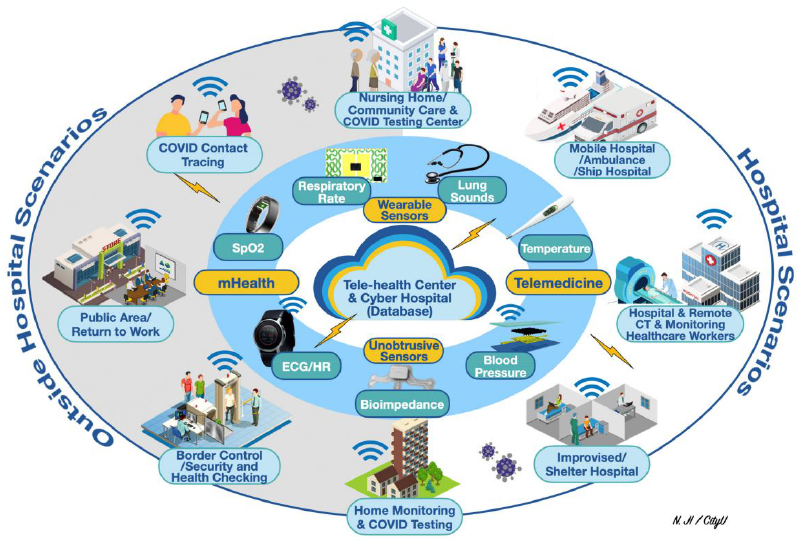
Figure 8. Practical use of medical wearable devices during the COVID-19 pandemic [45]. Reprinted/adapted with permission from Ref. [45]. Copyright 2022, IEEE.